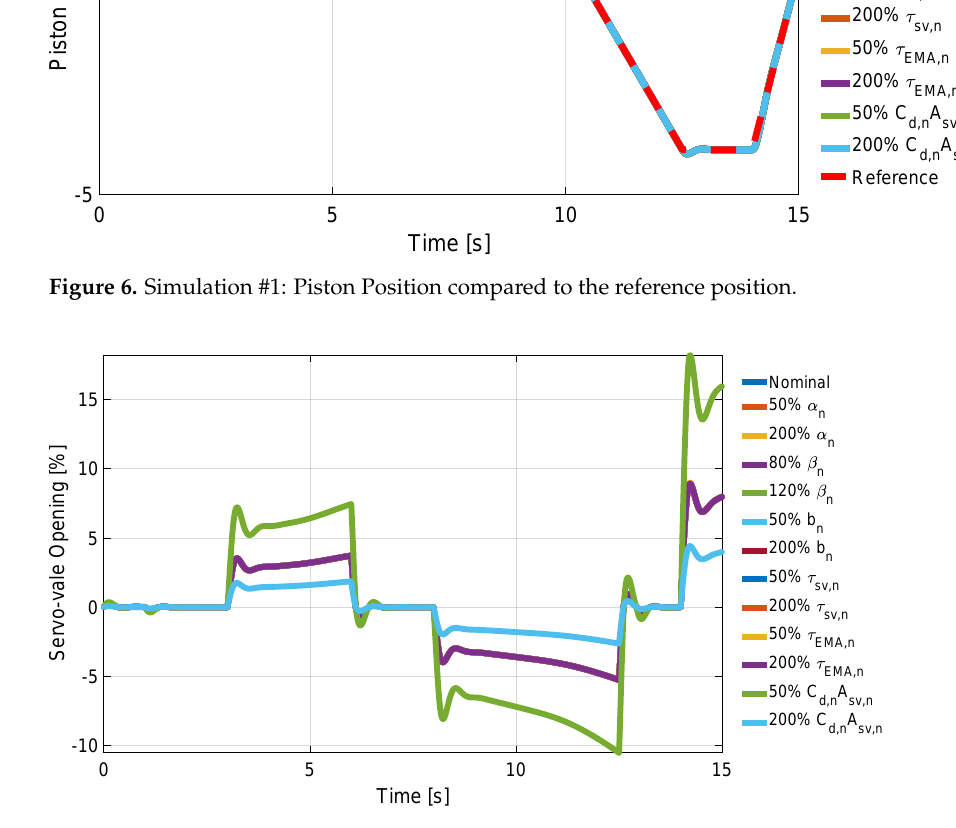
Figure 7. Simulation #1: Servo-valve opening